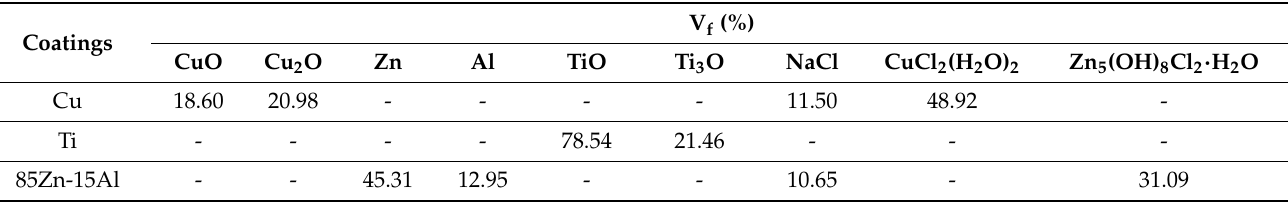
Figure 8. XRD of the corrosion products formed on the coating surface after immersion in 5% NaCl solution for 28 days. Table 6. V f (%) of the corrosion